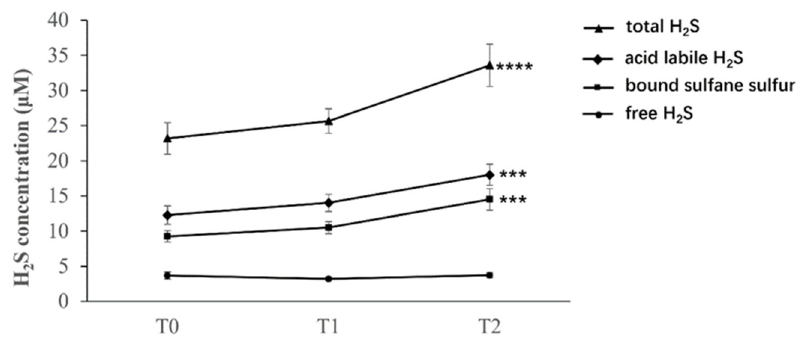
Figure 7. H 2 S levels in serum samples collected before the treatment (T0), immediately after the 12- day treatment (T1), and three days after completion of the treatment (T2). **** = p < 0.0001 vs. values at baseline (T0); *** = p < 0.005 vs. values at baseline